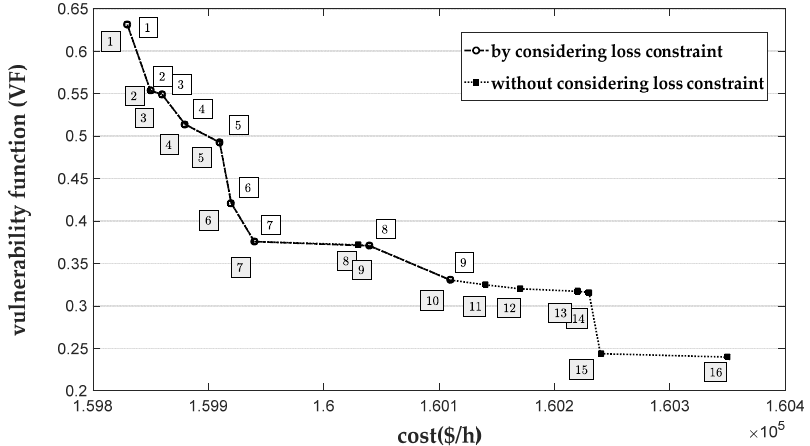
Figure 7. Obtained Pareto-optimal front for the IEEE 118-bus test system. Note: By increasing vulnerability function, resiliency is deteriorated.